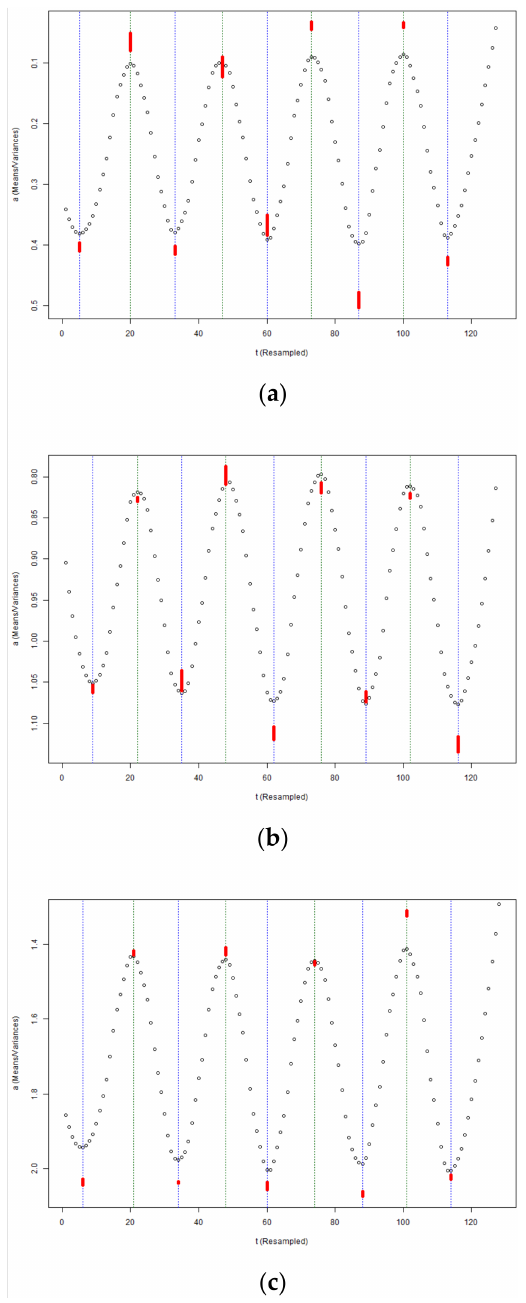
Figure 8. Means and peak/valley variances of resampled data for the 3.0-blade turbine. ( a ) Based on datasets recorded along the X axis with no wind imposed. ( b ) Based on datasets recorded along the Y axis with no wind imposed. ( c ) Based on datasets recorded along the Z axis with no wind